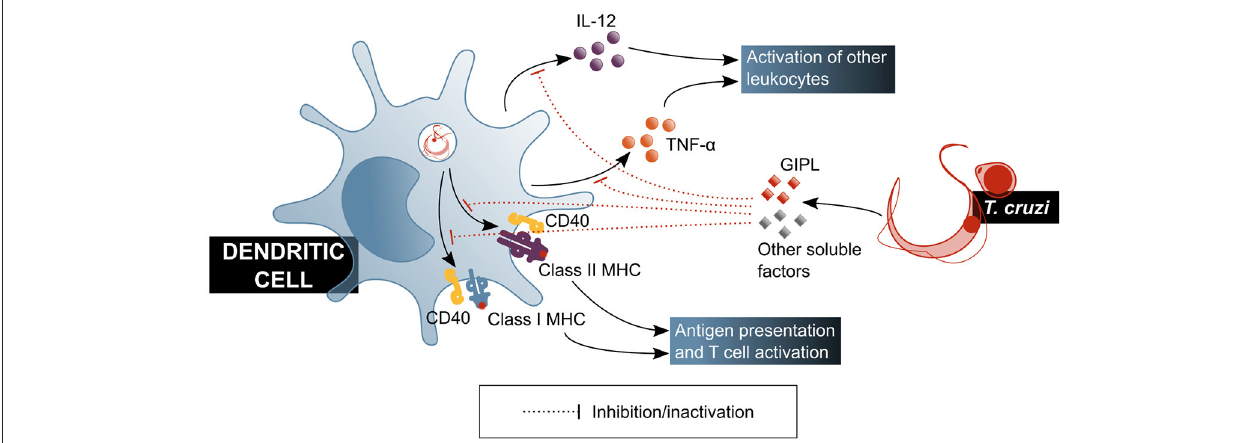
FIGURE 3 | T. cruzi modulates the functionality of dendritic cells, affecting their ability to activate mechanisms of the adaptive immune response. GIPL, T. cruzi glycosylinositolphospholipids. Blue shaded boxes represent factors and mechanisms considered beneficial for the host.